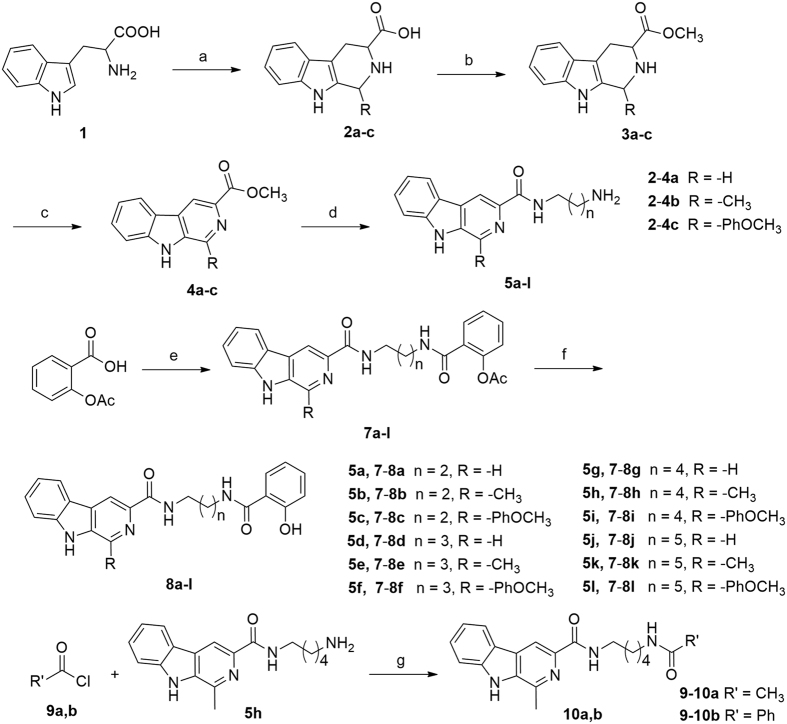
Reagents and conditions.(a) H+ or OH−, RCHO, reflux, 2–4 h, 81–86%; (b) SOCl2, MeOH, 0 °C, 1 h, and then reflux 6 h, 90–95%; (c) KMnO4, DMF, reflux, 6 h, 60–70%; (d) different diamines, EtOH, reflux, 3–5 h, 81–89%; (e) i) N-methylmorpholine, ethyl chloroformate, THF, 0 °C, 1 h; ii) Et3N, THF, 0 °C, 1–3 h, 55–68%; (f) NaOH, MeOH, r.t., 2 h, 90–96%; (g) triethylamine, CH2Cl2, r.t., 2 h, 75–79%.